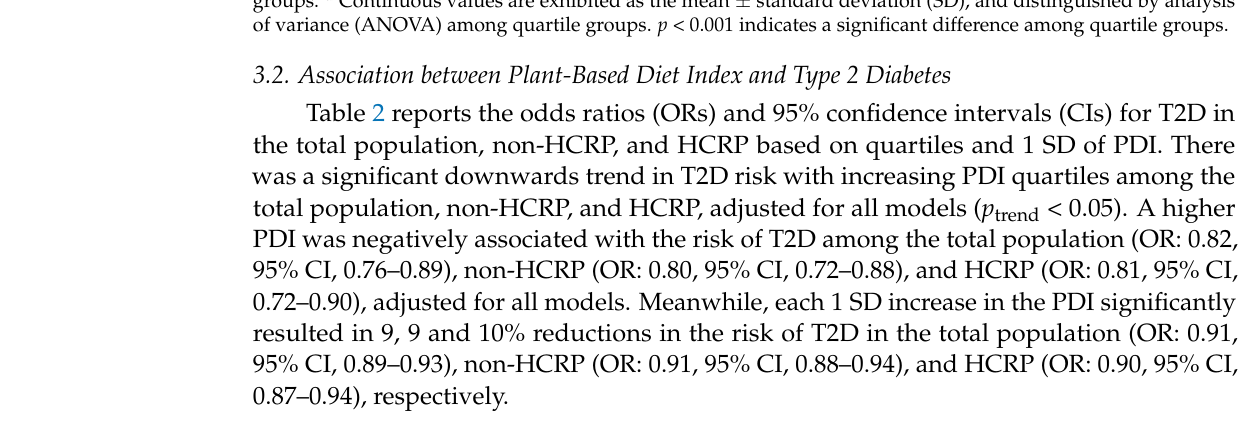
Table 2. Odds ratios (ORs) and 95% confidence intervals (CIs) for incident type 2 diabetes according to the plant-based diet index